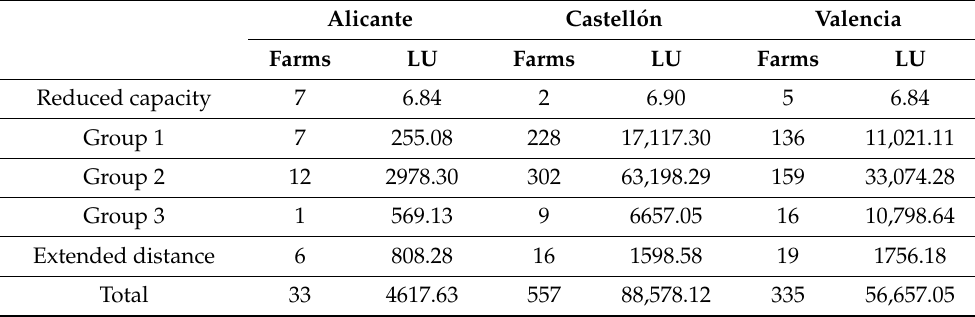
Table 1. Number of pig farms and livestock units (LUs) in the Valencian Community (VC) by type. Alicante Castell ó n Valencia Farms LU Farms LU Farms LU Reduced